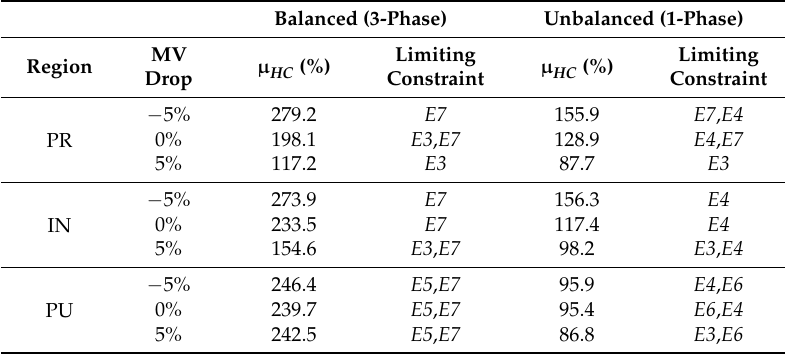
Table 6. Test Networks’ mean HCs and their limiting